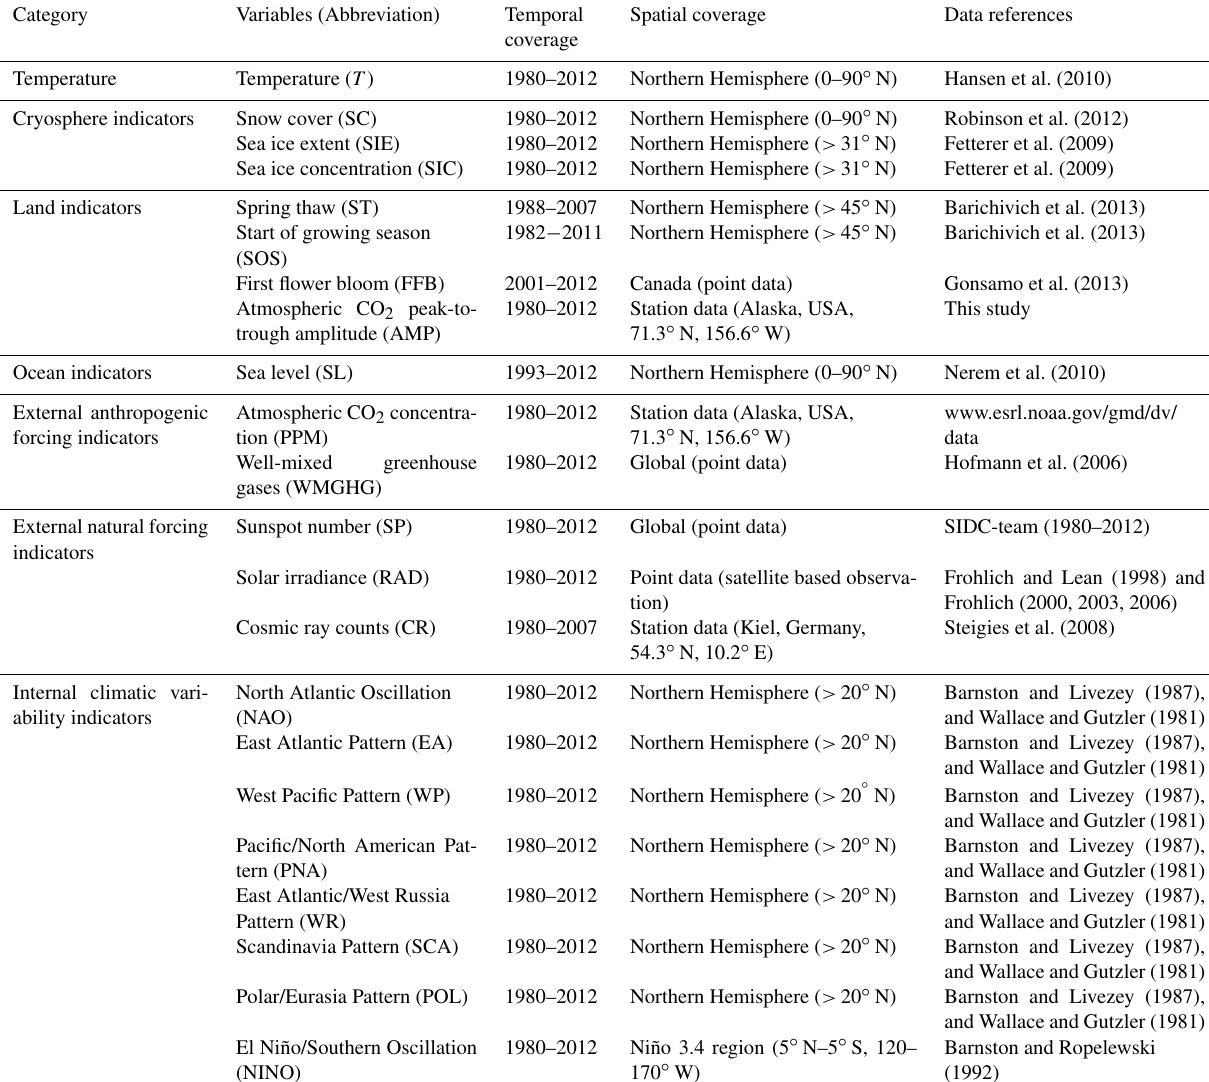
Table 1. Summary of key variables used in the current